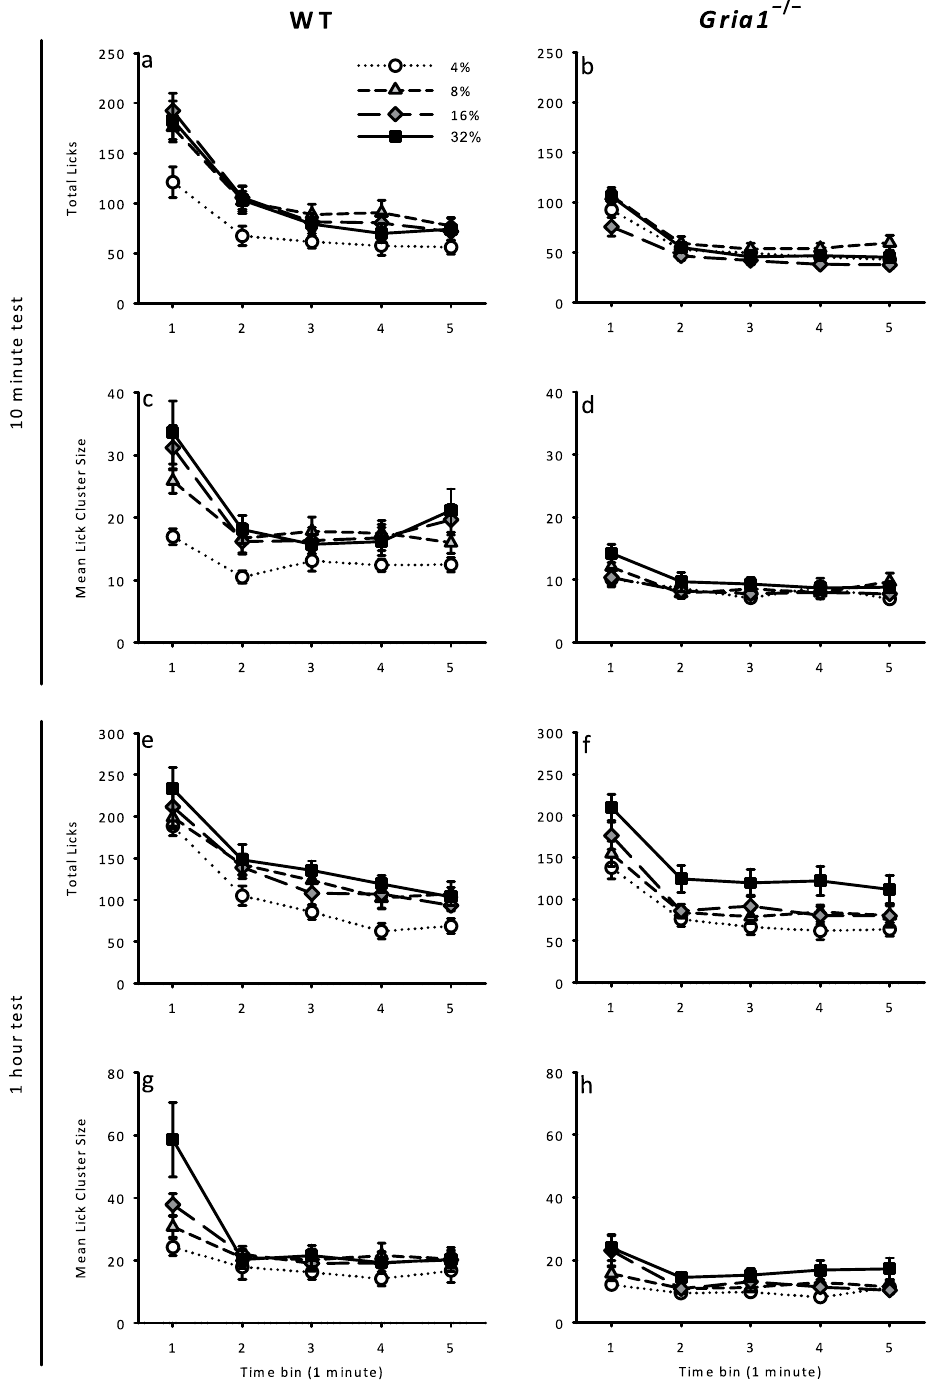
Figure 2. Initial lick rates and lick cluster sizes across the first five minutes of access to sucrose in one-minute time bins in hungry mice. Panels (a–d) show licking behaviour in Experiment 1 (10 minute test) and panels (e–h) show licking behaviour in Experiment 2 (1 hour test). Panels (a,b,e and f) show total licks. Panels (c,d,g and h) show mean lick cluster size. Error bars indicate ±